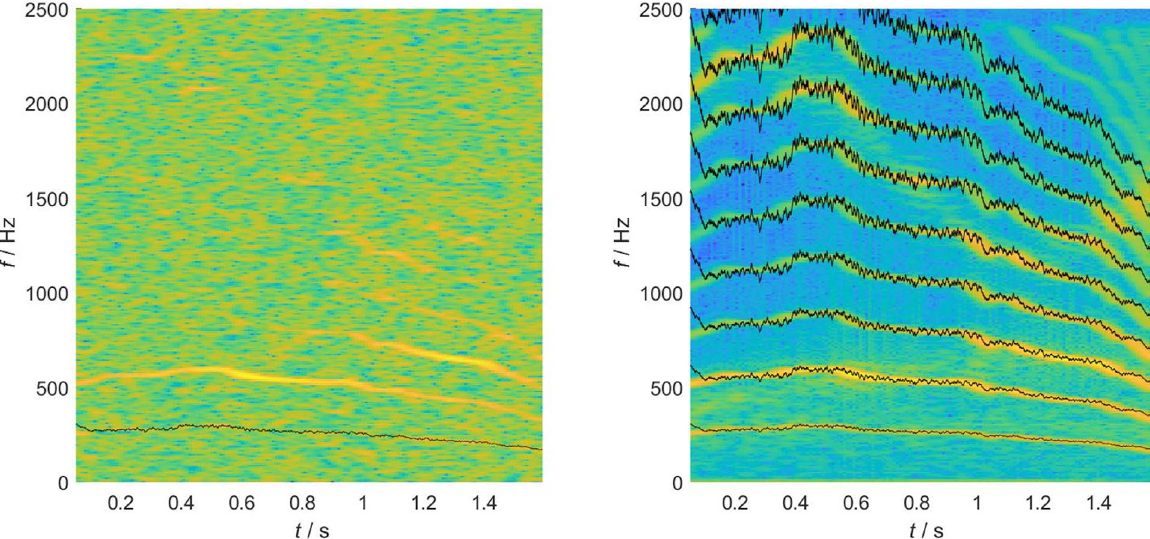
Figure 8. Spectrogram of a vocoded voiced speech signal with time-varying trajectories of fundamental frequency, fi rst and second formant. The left panel shows the spectrogram of the signal at an SNR of 0 dB as well as the fundamental frequency estimate derived from the noisy signal with a PM-HLL instance that was started at an oscillator frequency f c of 310 Hz (black curve). The right panel shows the spectrogram of the clean voice and again the PM-HLL estimate, together with its integer multiples 2 – 9. The PM-HLL instance catches the fundamental frequency trajectory at about 100 ms into the signal and keeps track throughout the duration of the signal. Note that the spectrogram of the noisy signal does not show the fundamental, and most of the time only the second harmonic is